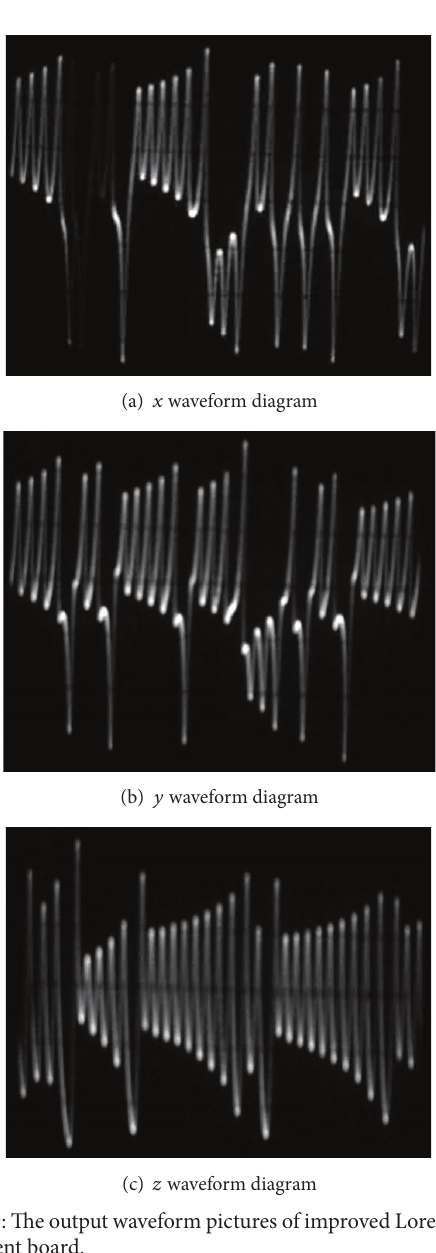
Figure 8: Simulation phase diagram.